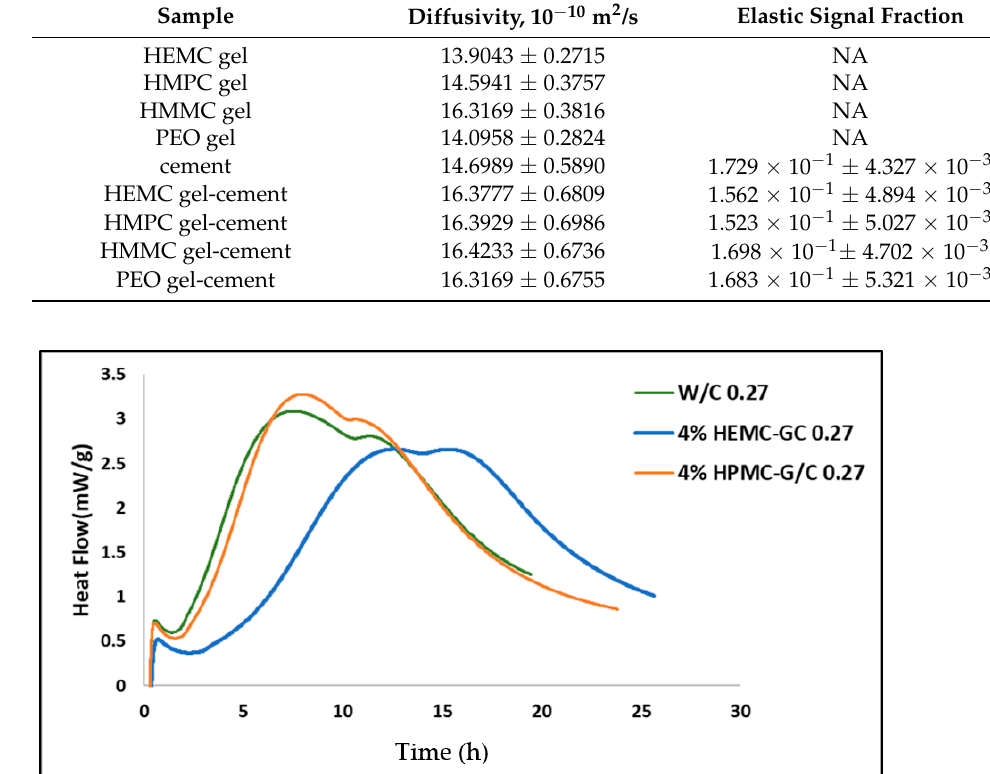
Figure 10. Plot of Lorentzian HWHM versus Q 2 for all samples .